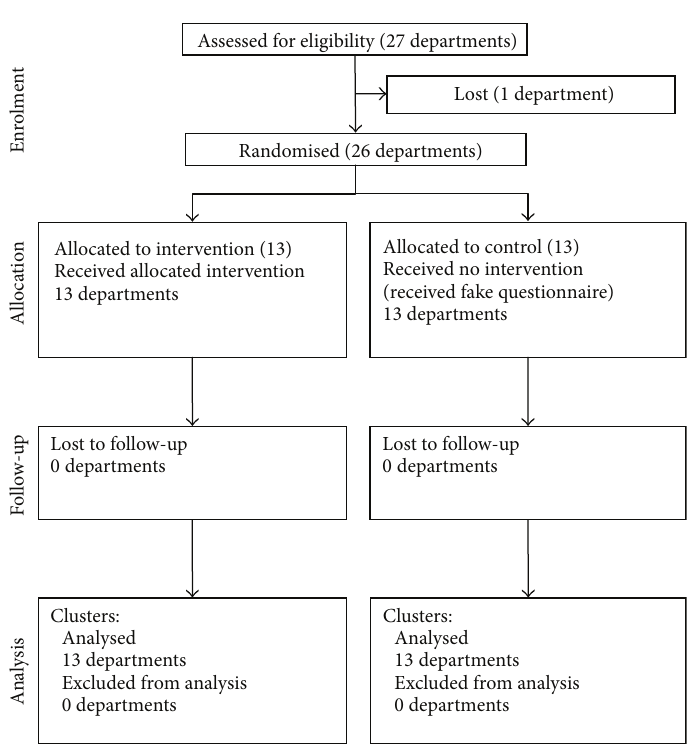
Figure 1: Diagram flow of clusters.